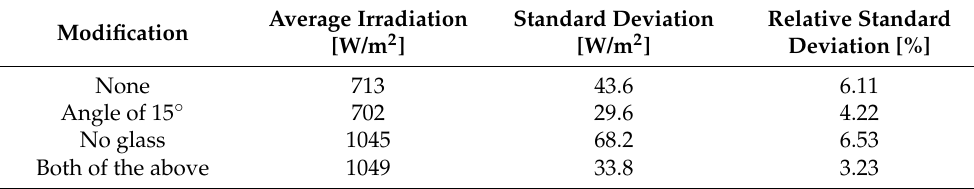
Table 3. Parameters of irradiation of the 2 × 160 W lamp configuration with